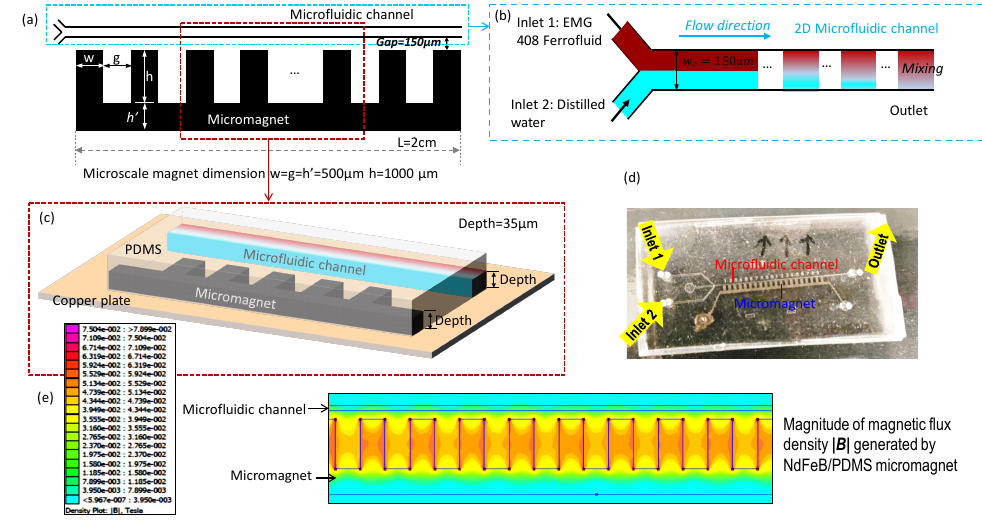
Figure 1. The schematic of the rapid mixing microdevice with embedded microscale magnet. ( a ) The two-dimensional overview of microfluidic channel and micromagnet. The microscale magnet is fabricated beside the microfluidic channel, and the distance between the microscale magnet and the microfluidics channel is gap = 150 µ m. The width, length, and gap of the microscale magnet